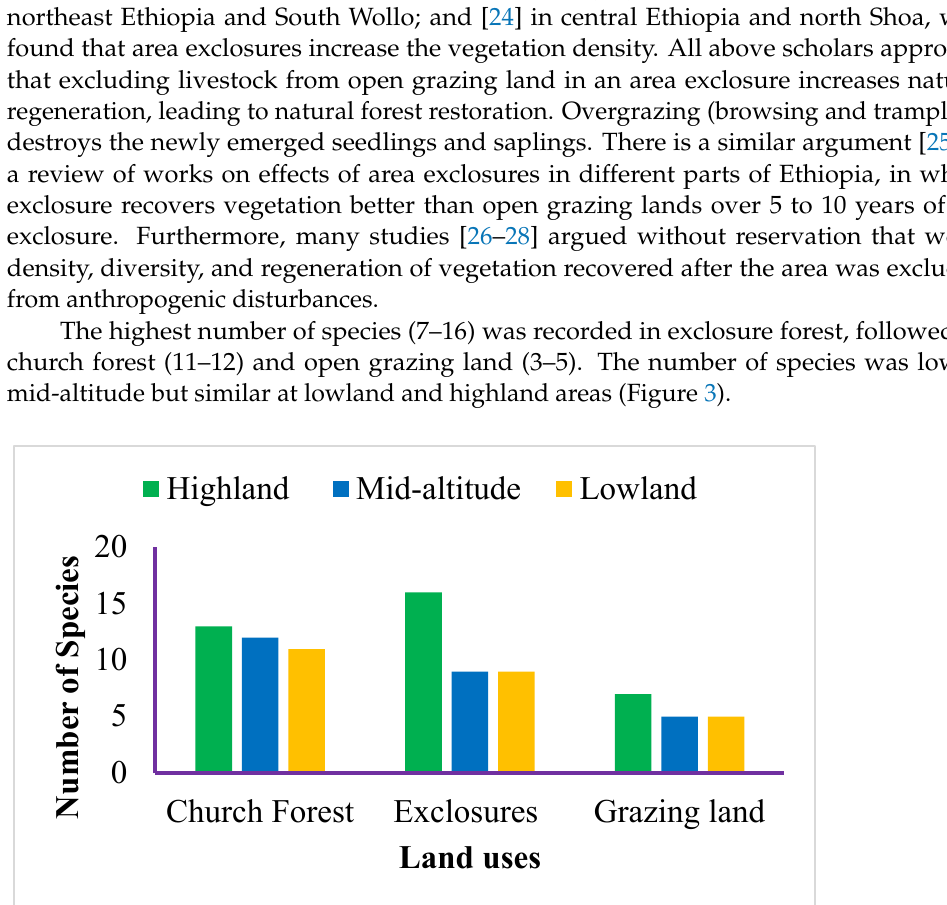
Figure 3. Species richness of different land uses at different sites. Species diversity was high (0.78–2.27) in church forests, followed by exclosures (1.1–1.73) and open grazing lands (0.48–0.8). The dominance and evenness index is highest in church forests, followed by exclosures and open grazing lands (Table 2).